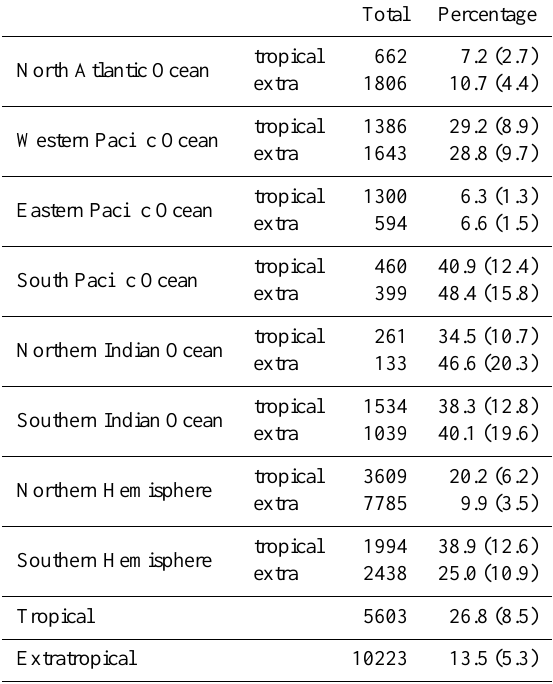
Table 4. Summary of Table 3, reporting the percentage of tropical and extratropical cases binned into ocean basins, hemispheres, and tropics/extratropics. The column “Percentage” reports the percent- age of possible overshootings computed with Eq. (2) and within brackets the percentage of possible overshootings computed with Eq. (3).